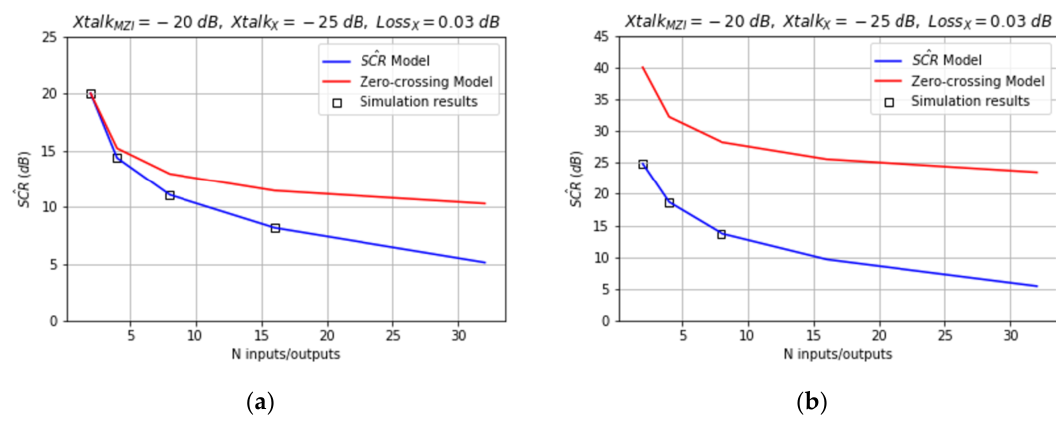
Figure A3. ˆ SCR values of Bene s ( a ) and dilated Bene s ( b ): solid blue curves for the complete model; solid red curves for the zero-crossing model. Black square dots are the simulation results.